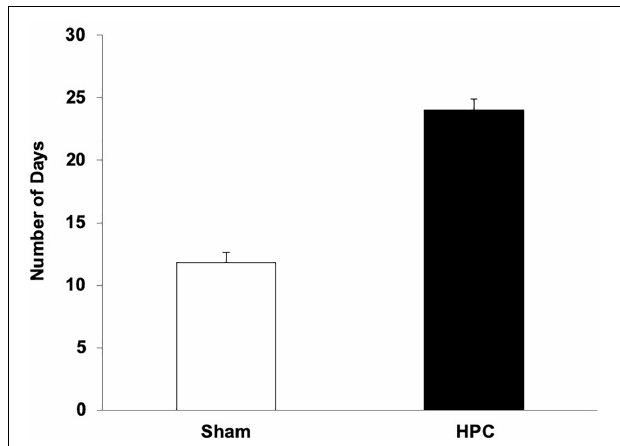
FIGURE 4 | Mean (+SEM) number of days for naïve Sham and HPC rats to learn the visual discrimination after their surgery. The rats with HPC lesions took twice as many days to learn the visual discrimination as control rats ( p < 0.05), suggesting anterograde amnesia and that the non-HPC systems need many trials to acquire a visual